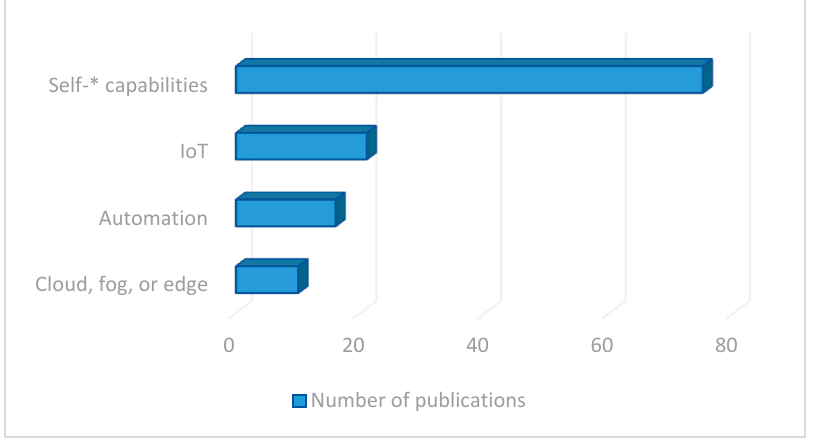
Figure 2. Number of publications by topic.